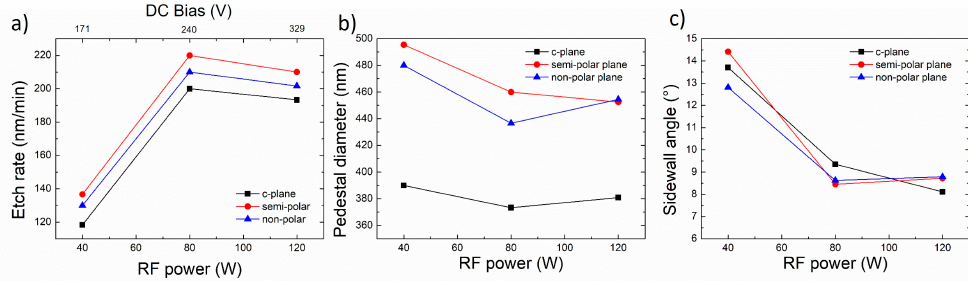
Figure 10. ( a ) Etch rate, ( b ) base diameter and ( c ) sidewall angle of the c -plane, (1122) semi-polar and (1120) non-polar GaN layers as a function of RF power.